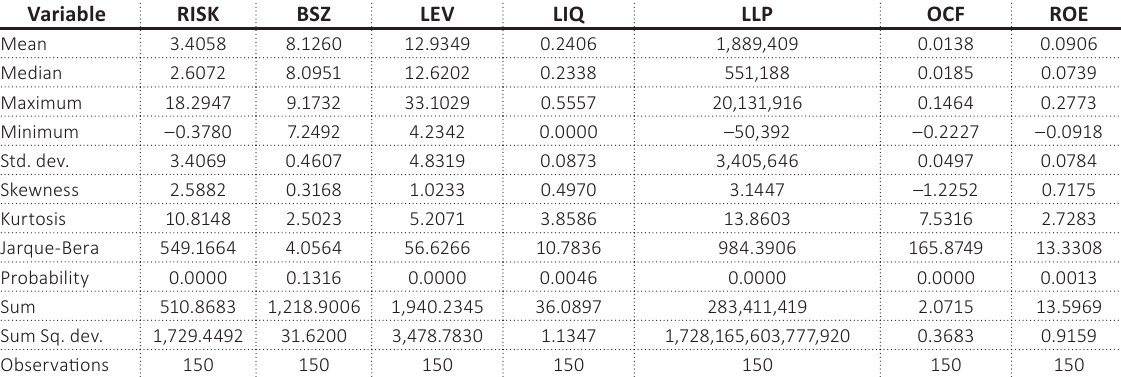
Table B1. Descriptive statistics for variables included in the